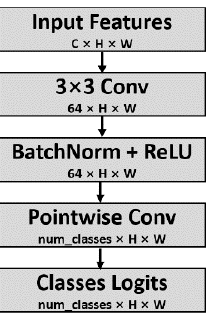
Figure 6. Structure of the semantic segmentation